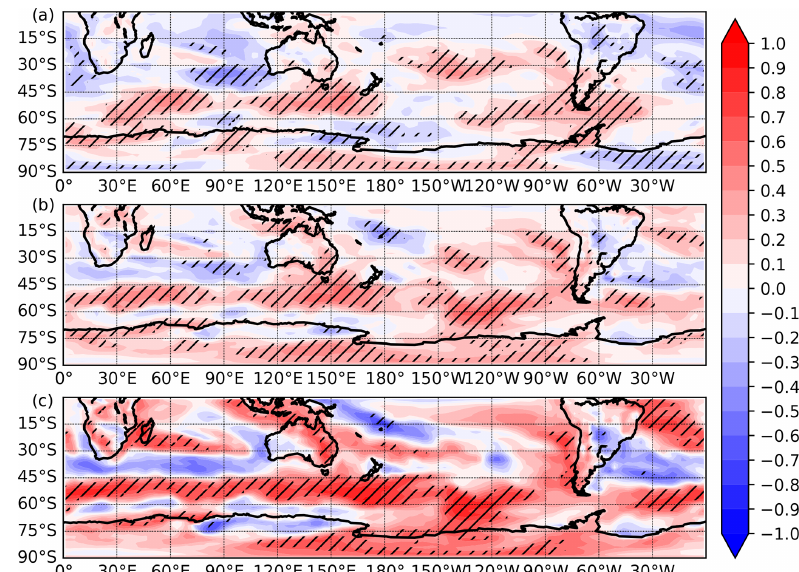
Figure 9. Correlation between the (a) 31 year, (b) 61 year, and (c) 91 year SAM–SAT running correlation at each grid cell and the model- derived n3.4 index. The n3.4 index is filtered with a corresponding 30, 60, or 90 year filter. Hatched regions indicate p < 0 . 05.